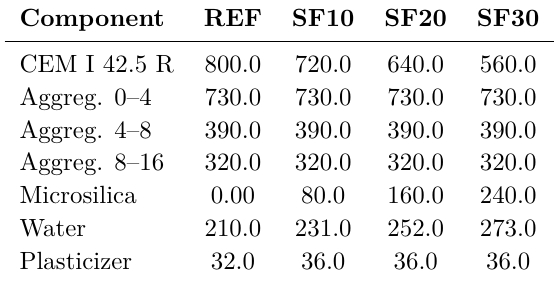
Table 1. Compositions of tested mixtures in [kg · m − 3